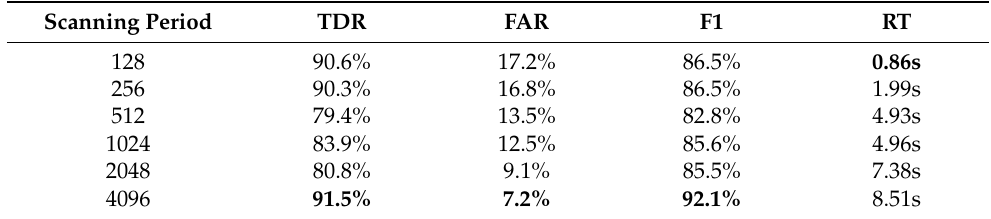
Table 3. The anomaly detection results under different scanning period (the channel width is 20).